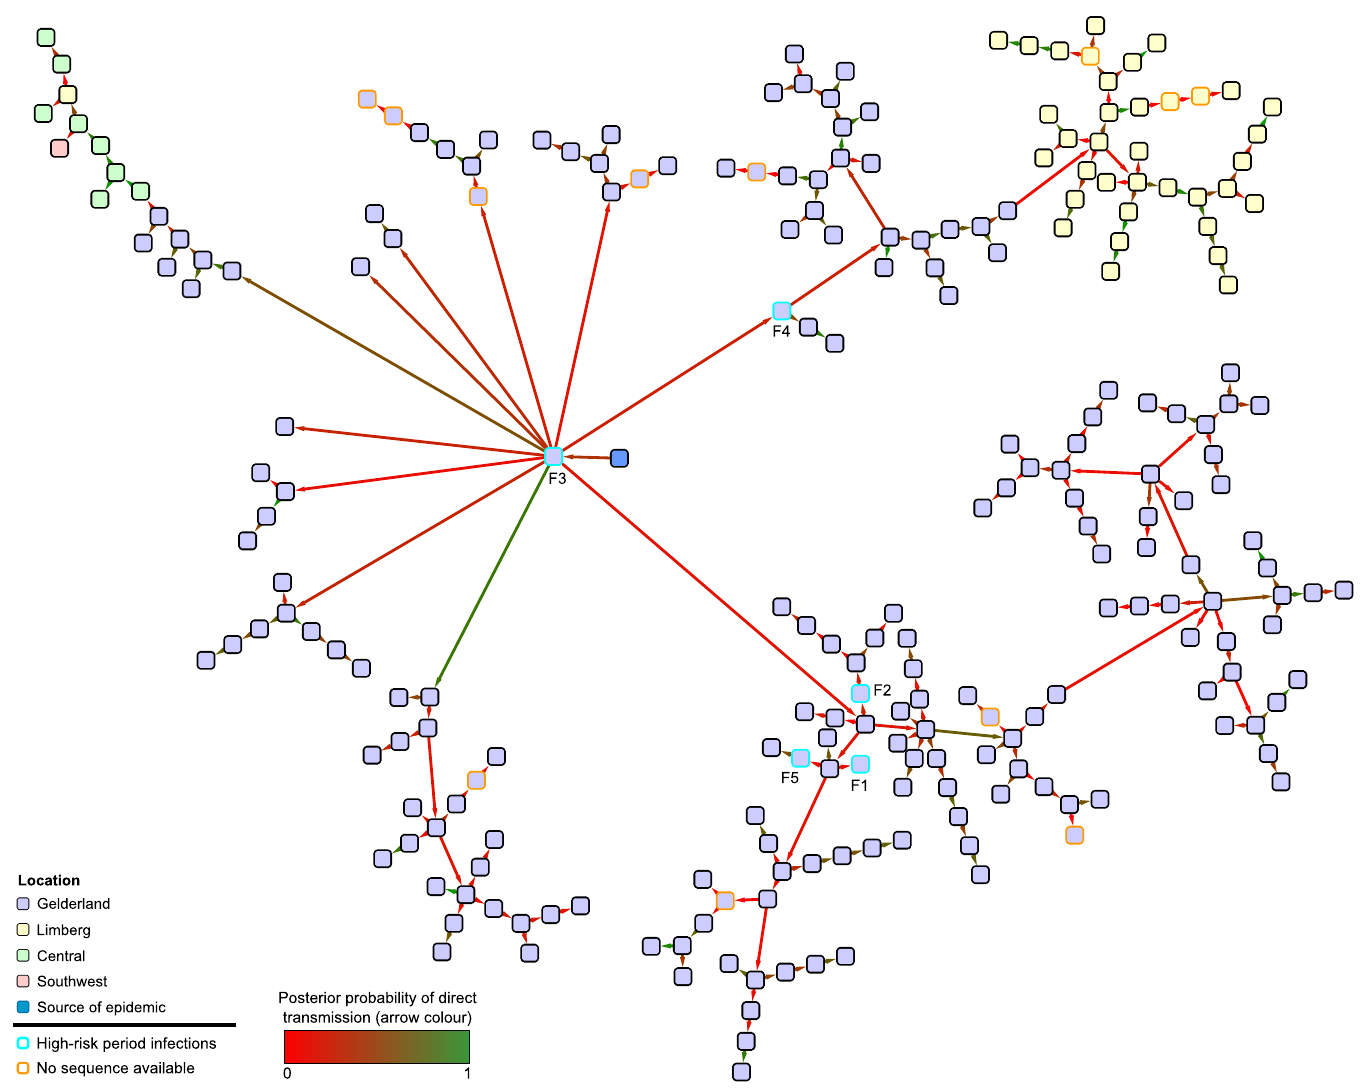
Fig 5. Maximum parent credibility transmission tree for the H7N7 outbreak. Nodes represent farms and are coloured by geographical region. Arrows represent direct transmissions and are coloured by the posterior probability of this particular direct infection. The cyan-bordered nodes, which are also labelled with farm ID numbers from previous literature [18], are were detected during the “ high-risk ” period before the implementation of control measures. Orange-bordered nodes are farms for which no sequence was available.